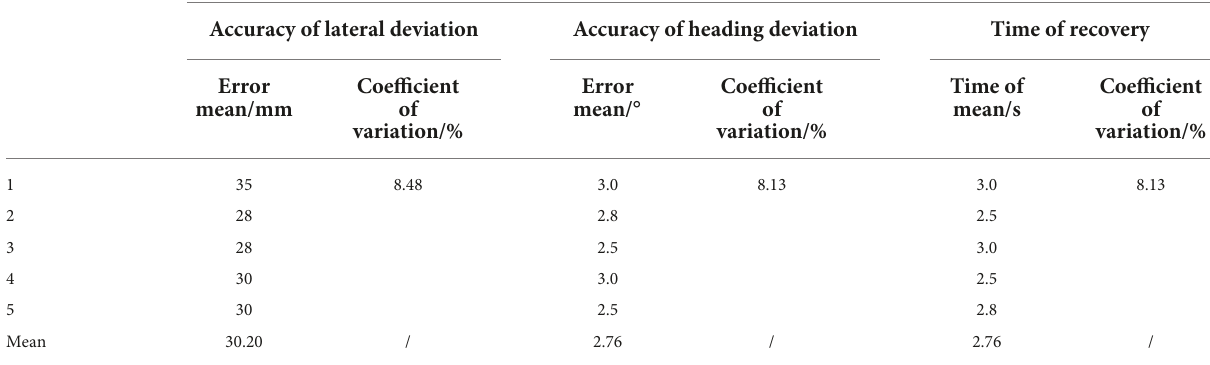
TABLE 8 Test results of detection performance of a concave road edge plane turning to a normal road edge